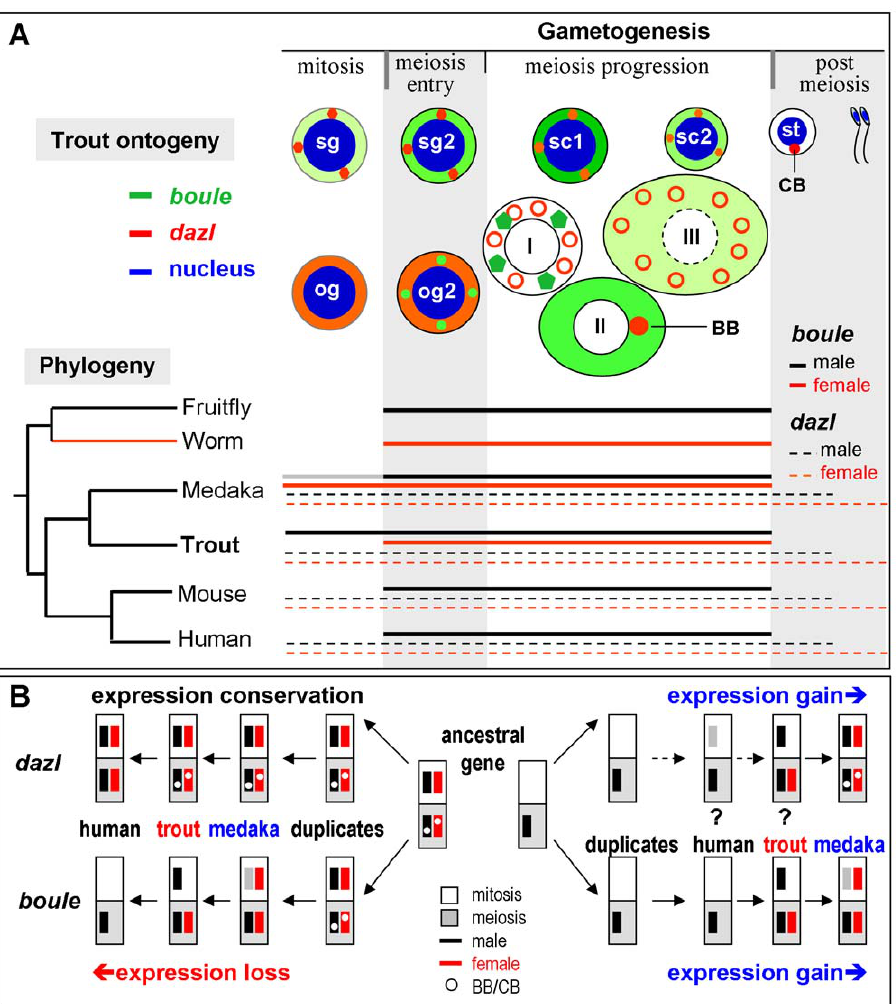
Figure 10. Evolutionary divergence of boule expression. (A) Left, Phylogeny. The ancient member boule exists in all metazoans. Sex specificity of expression is indicated different colors (male, black; female, red; color intensity, relative expression level). Right, gametogenic expression. Expression pattern is indicated by extent of horizontal lines. Major stages of gametogenesis are diagramed as a timeline for boule gene expression. Unisexual meiotic expression of boule occurs in male fly, mouse and human (most abundantly in primary spermatocytes) and in female worm. Our previous work and this study demonstrate that bisexual boule expression occurs in both fish species. Data obtained in this study from trout clearly demonstrate that boule expression in the ovary is restricted to oogenic meiosis, in contrast to both premeiotic and meiotic expression in medaka. Notably, the male mitotic expression of boule is weaker than its meiotic expression. (B) Alternative models of evolution. In the loss of expression model, the ancestral gene and its initial duplicates have bisexual expression throughout gametogenesis: One duplicate has conserved the original expression pattern and become dazl , whereas the other duplicate has undergone selective loss of expression and become boule that ultimately displays male meiotic expression in mammals [1]. In the gain of expression model, a reversed situation applies. The situations we found in medaka [11,18] and trout (this study) appear to represent two intermediate steps of boule evolution and supports either model. Highly conserved bisexual dazl expression in mitotic and meiotic germ cells favors the gain of expression model, whereas unisexual meiotic expression of boule in mammals and more importantly, in invertebrates as the only family member seemingly supports the gain of expression model. Question marks denote hypothetical intermediate steps in the gain of expression model.